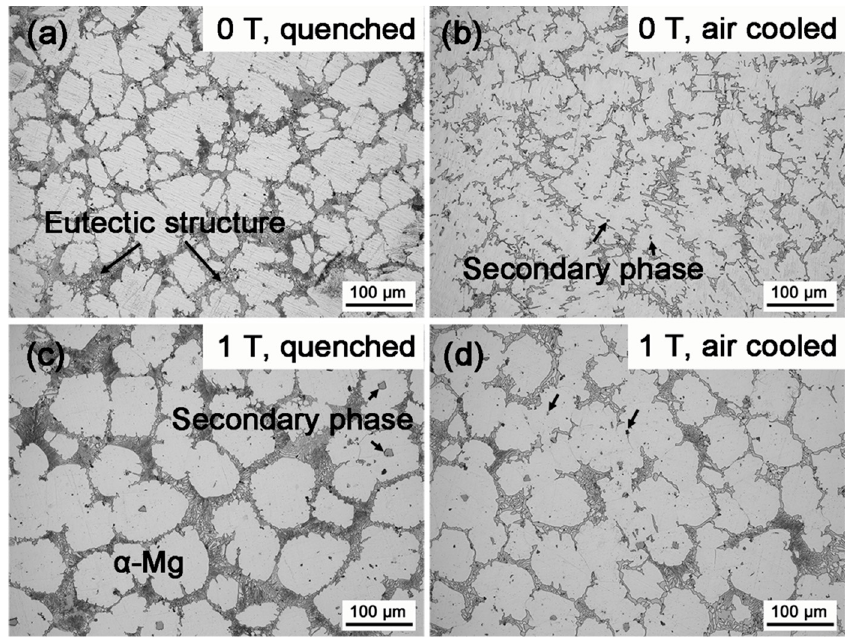
Figure 7. OM images of the quenched Mg–Al–Gd alloy under ( a ) 0 T and ( b ) 1 T, and the air cooled alloy under ( c ) 0 T and ( d ) 1 T.